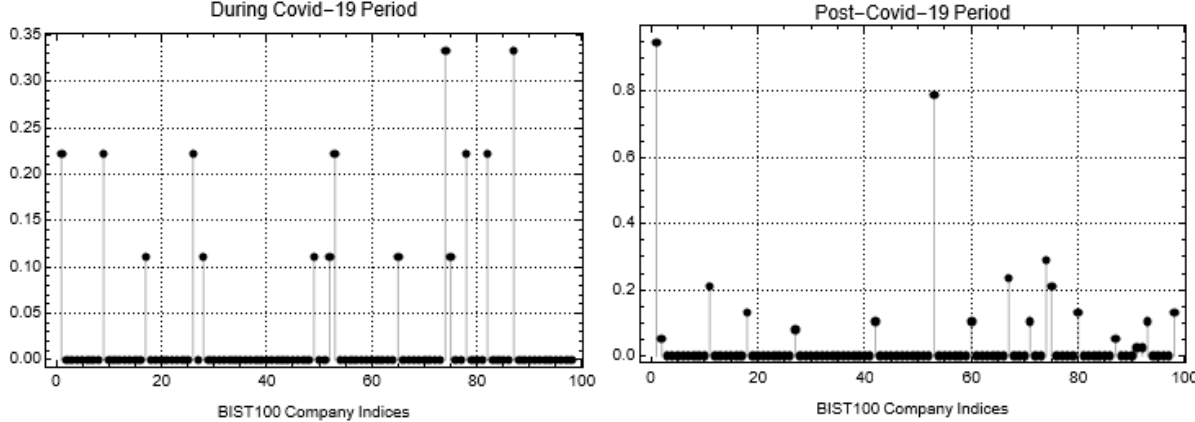
Figure 3. P v ( k ) distributions for network-induced soft sets with respect to two periods of COVID-19 stress. Note: The distribution of the left corresponds to the period during COVID-19, while the distribution of the right corresponds to the period post-COVID-19.